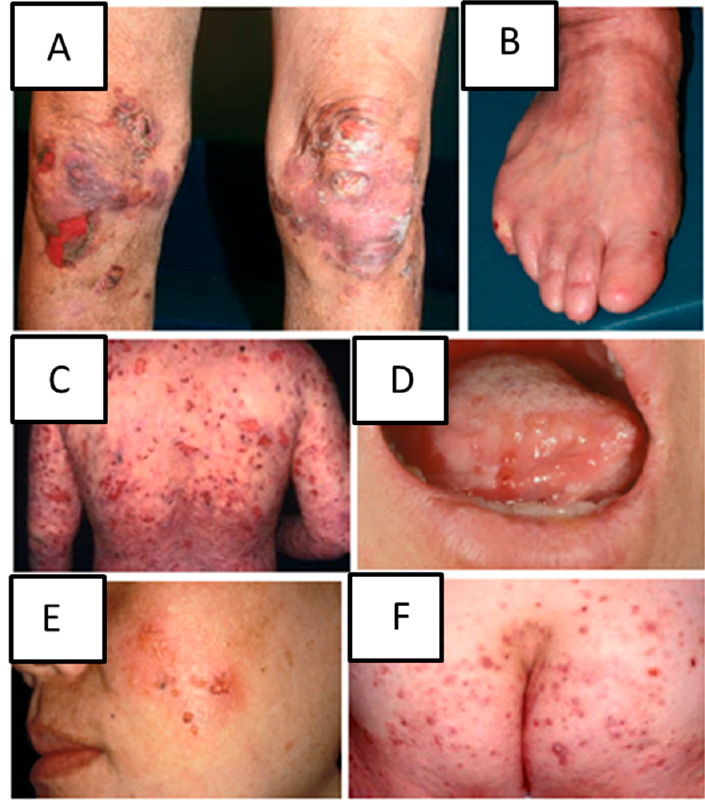
Figure 1. Clinical manifestations of inflammatory epidermal bullosa acquisita (EBA). Blisters and scars on the knee ( A ); loss of toenails ( B ); inflammatory blisters on the back and arms in bullous pemphigoid-like EBA ( C ); oral mucosal involvement in mucous membrane pemphigoid-like EBA ( D ); localized blisters on the cheek in Brunsting-Perry pemphigoid-like EBA ( E ); blisters on the buttock in linear IgA dermatosis-like EBA ( F ). Figure adapted with permission from Kim and Kim 2013 JEADV and modified [6].